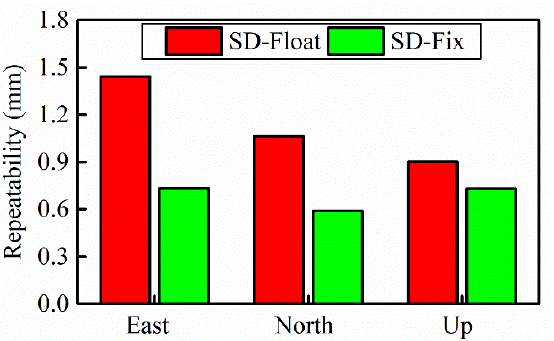
Figure 4. Repeatability of the baseline solutions in east, north, and up directions for SD-Float and SD-Fix solutions.